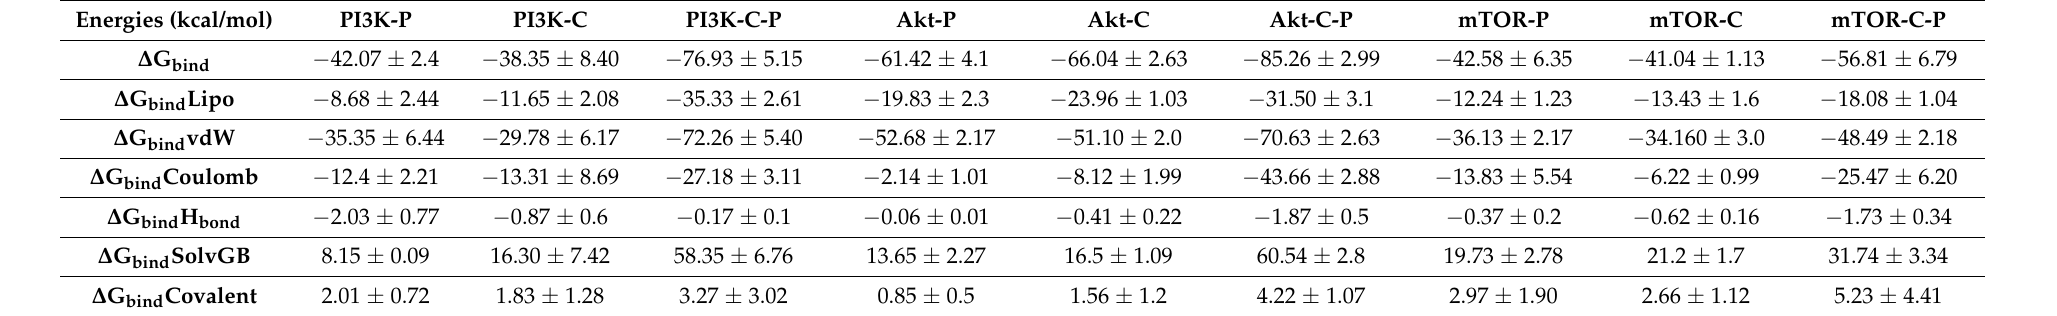
Table 2. Binding free energy components for PI3K, Akt, and mTOR complexed with plumbagin, curcumin, and plumbagin–curcumin combination calculated by